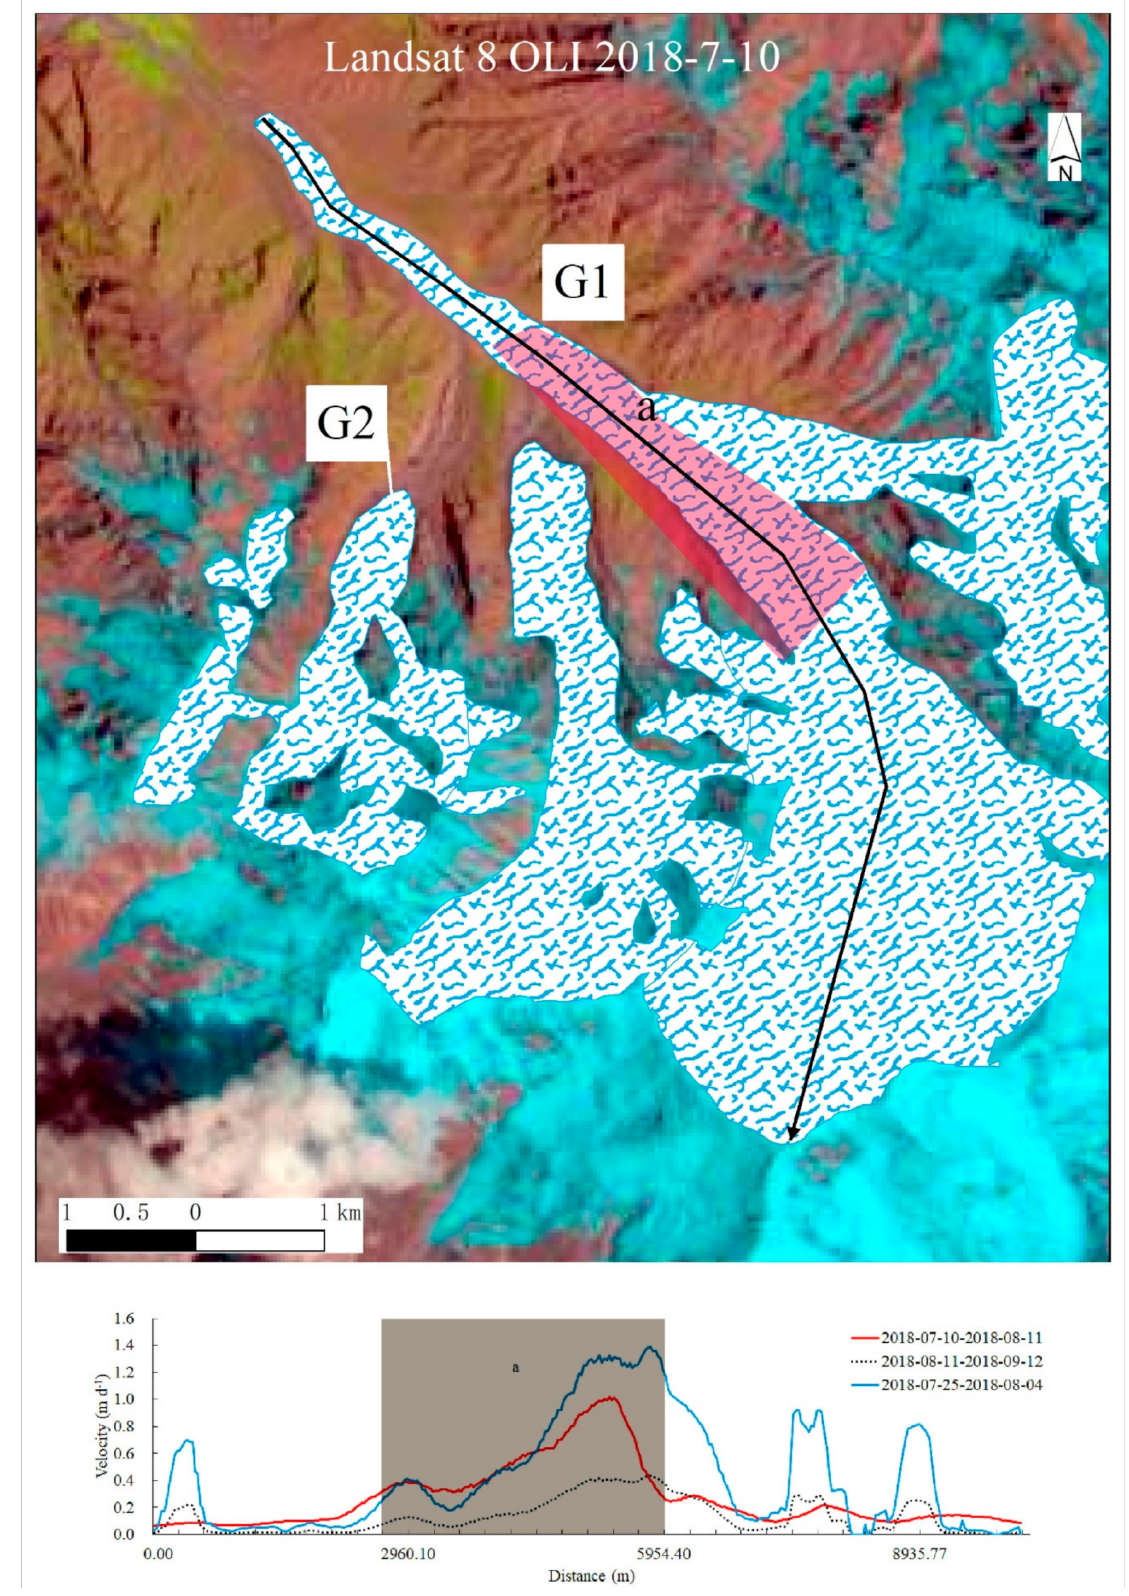
Figure 7. The ice velocities and longitudinal profiles of G1 from 10 July 2018 and 12 September 2018 (from glacier tongue to glacier